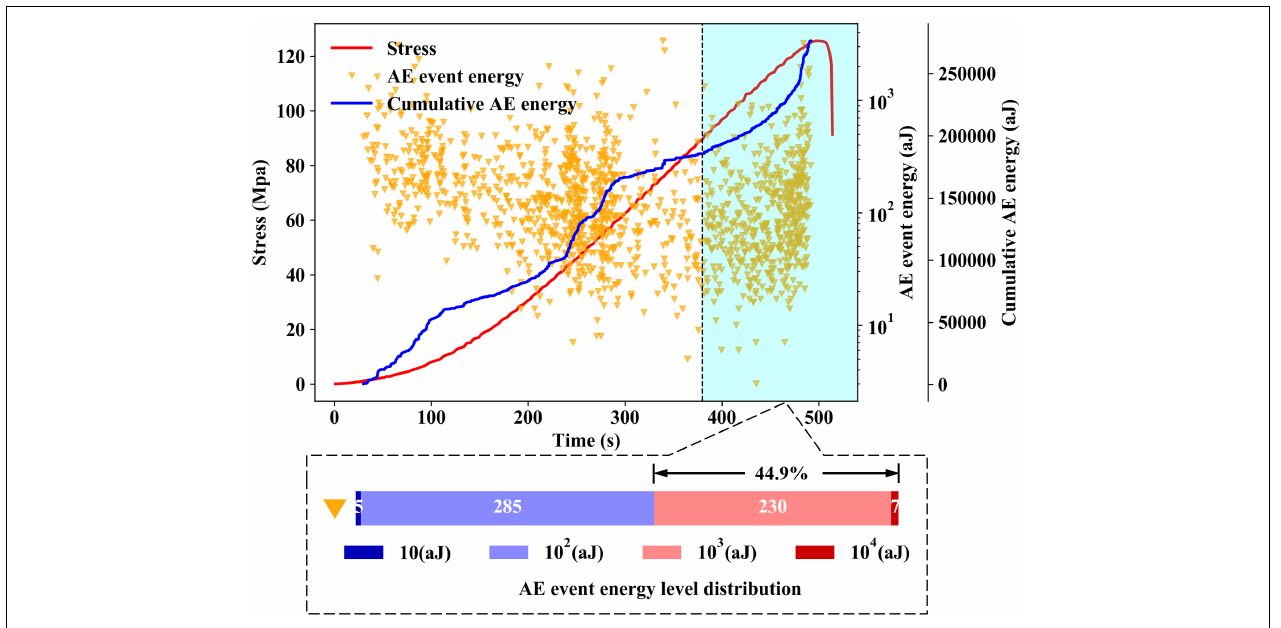
FIGURE 5 | Evolution and distribution of AE events energy versus time in dry granite. The crack propagation phase corresponds to the concentrated release of energy (highlighted area), and high energy level acoustic emission events account for 44.9%. AE sources tend to fracture more violently in critical state of rock burst.